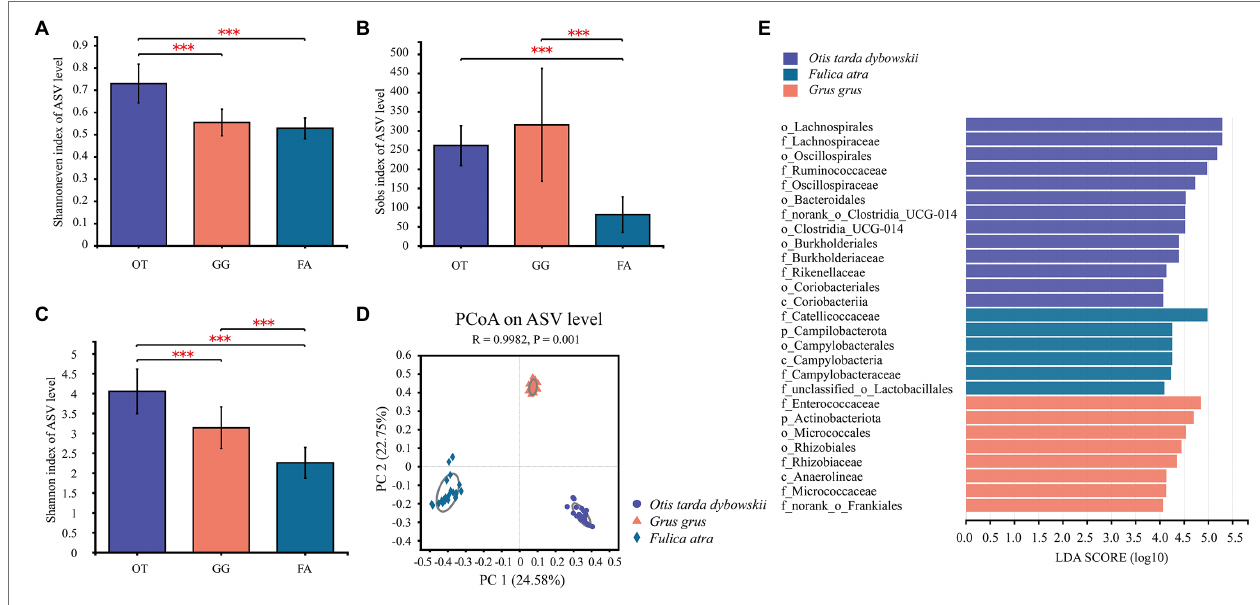
FIGURE 3 | Boxplot showing the differences in alpha diversity among the three wintering wild bird species (*** p < 0.001). (A) Shannoneven, (B) Sobs, and (C) Shannon indices. OT, Otis tarda dybowskii ; GG, Grus grus ; and FA, Fulica atra . (D) PCoA of the gut microbial communities of the three bird species according to the Bray–Curtis distances. The differences among the three groups were assessed using the Analysis of Similarities (ANOSIM) with 999 permutations. (E) LEfSe analysis on the gut microbial biomarkers of the three bird species (LDA > 4, p <